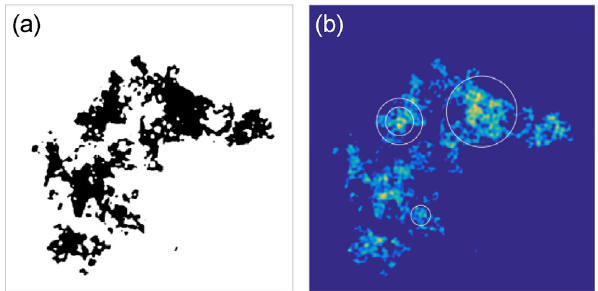
Fig. 2 Numerical simulation of the normal contact between a rough surface and an elastic half-space: (a) contact area at a given indentation depth; (b) pressure distribution in the